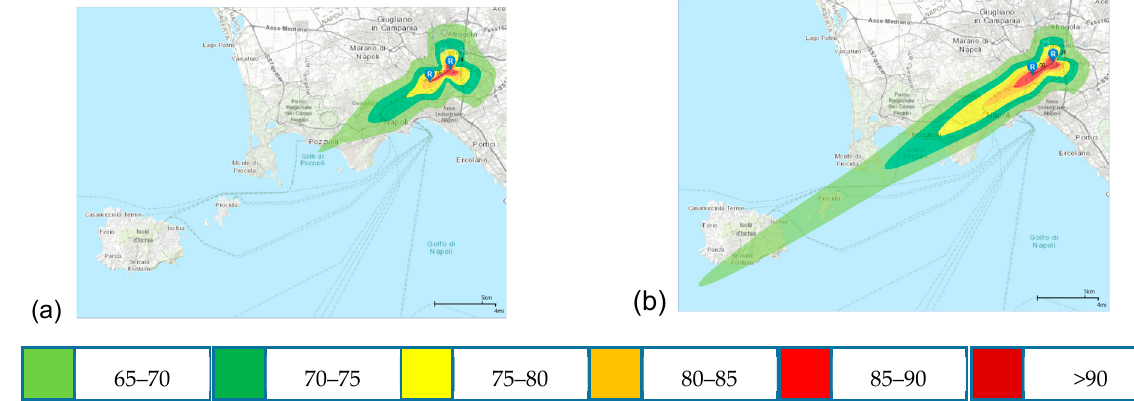
Figure 39. Graphical representation of equal loudness contours for the conventional ( a ) and hybrid ( b ) configurations, in terms of L AE (dB-A), for a standard runway-24 take-off.